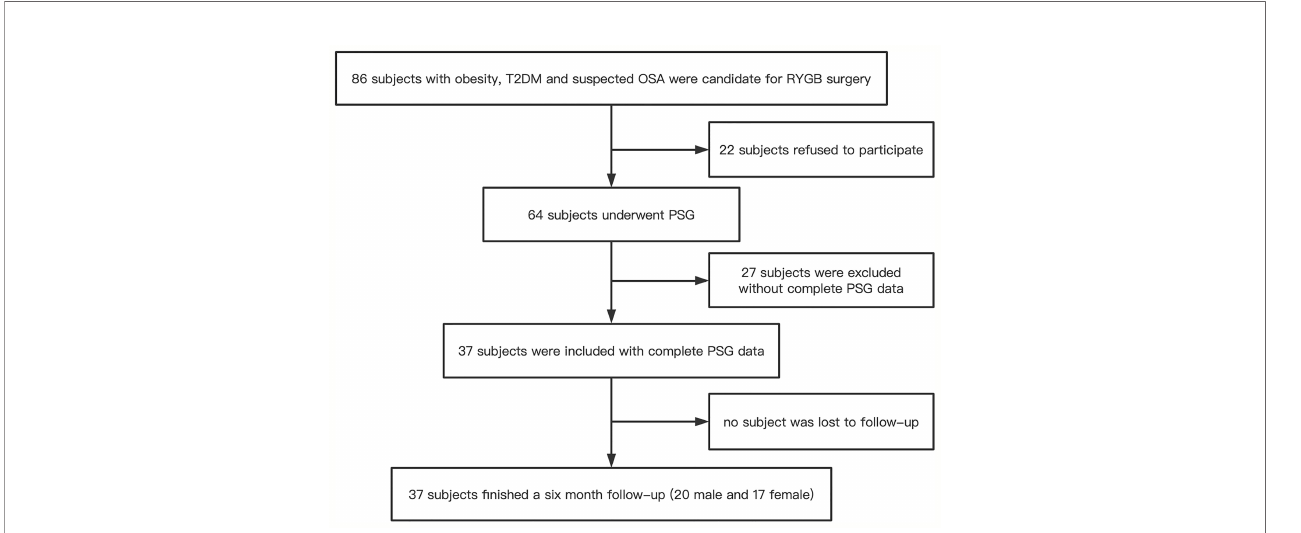
FIGURE 1 | Flow diagram of the recruitment process. T2DM, type 2 diabetes; OSA, obstructive sleep apnea; RYGB, Roux-en-Y gastric bypass surgery; PSG,